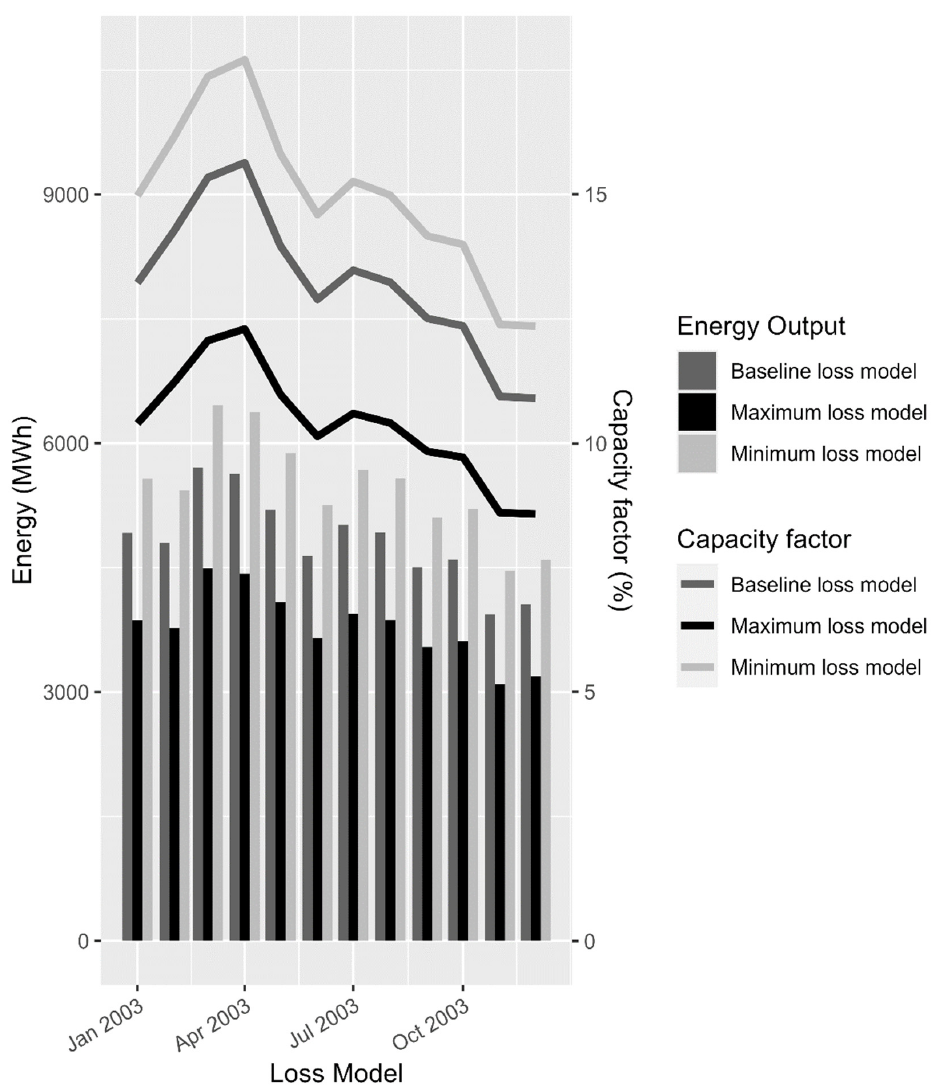
Figure 5. Energy output per month and CF estimations for each season using maximum, baseline and minimum loss models of the proposed prefeasibility tool.